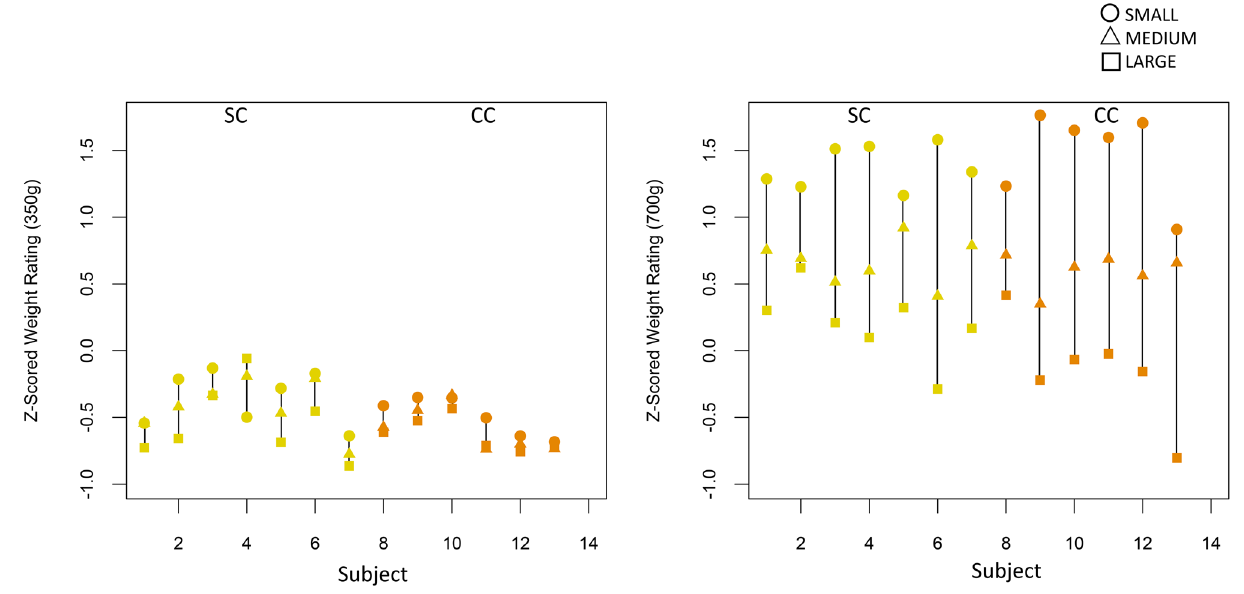
Figure 4. Experiment 2 (with only visual size information); z-scored weight ratings of all individuals in the Sighted Control group (SC, yellow) and Congenital Cataract group (CC, orange) groups (A) for the 350 g and (B) for 700 g weights (Experiment